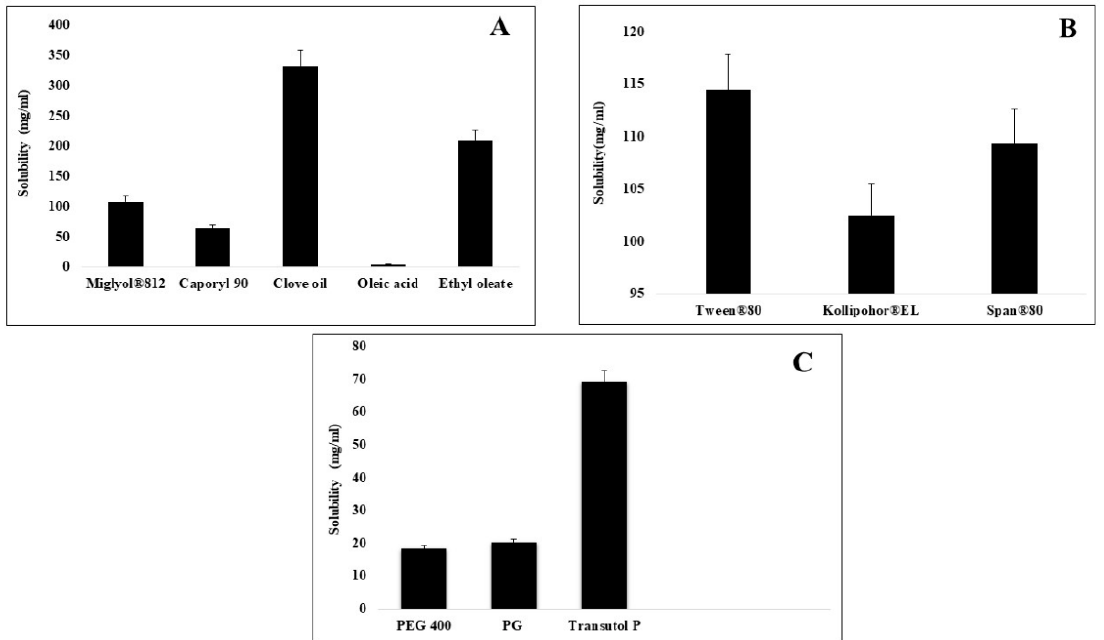
Figure 1. Comparative solubility of cefixime in various oils ( A ), surfactants ( B ), and co-surfactants ( C ) evaluated at 25 °C.